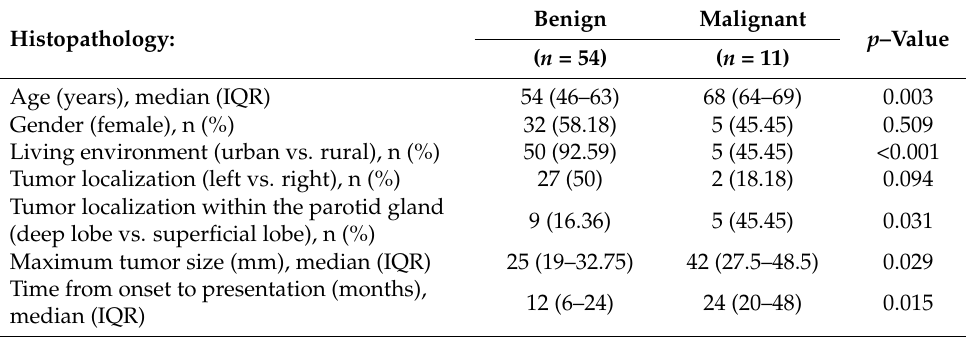
Table 1. Patient demographics and benign and malignant tumor characteristics.